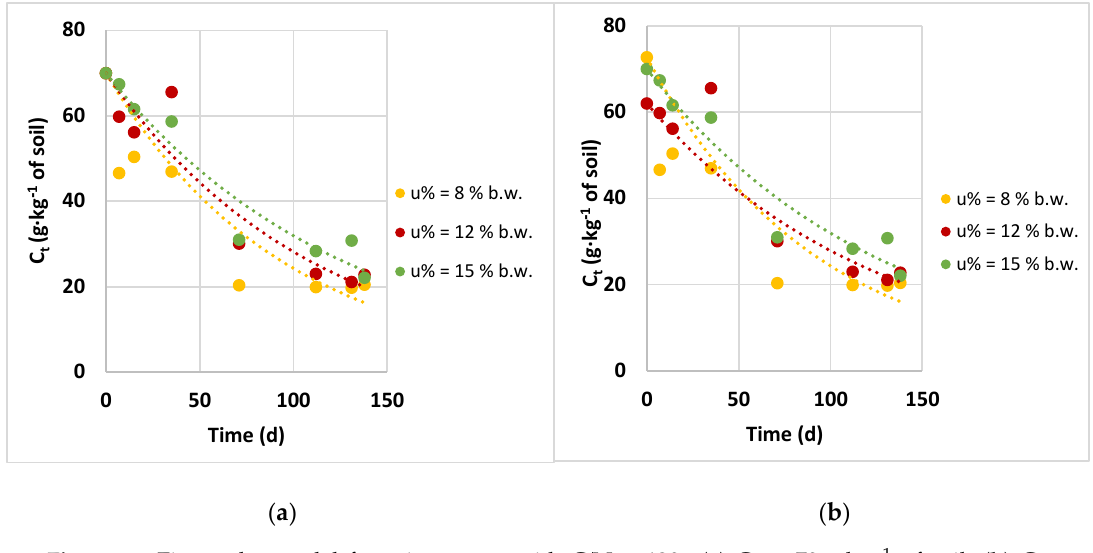
Figure 8. First-order model for microcosms with C / N = 120: ( a ) C 0 = 70 g · kg − 1 of soil; ( b ) C 0 was measured.